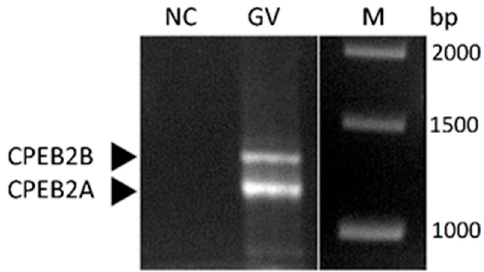
Figure 2. Two splice variants of CPEB2 transcript in porcine oocytes. CPEB2A (short variant) and CPEB2B (long variant) were detected using RT-PCR. GV = oocyte stage, NC = negative control, M = marker, bp = marker size. The experiment was repeated three times, with 280 oocytes per experiment.